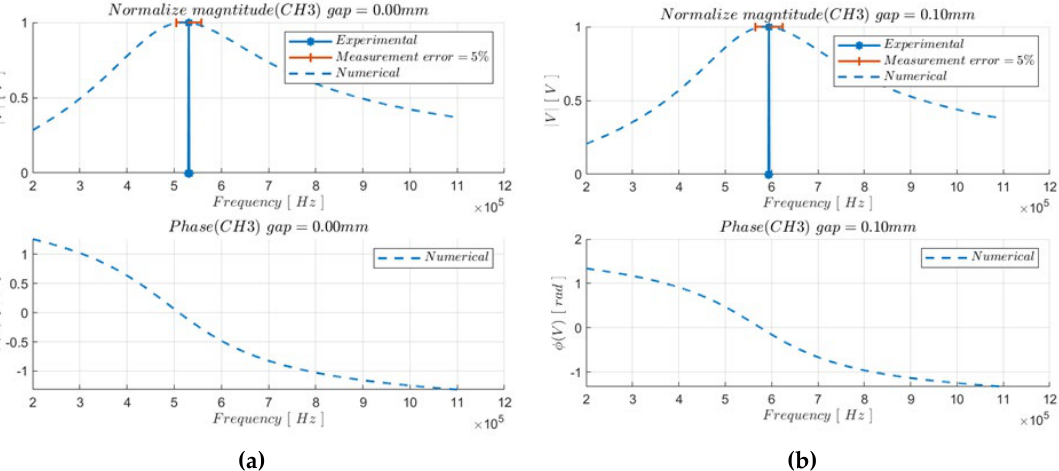
Figure 16. ( a ) Focus of the CH3 frequency response at 0.00 mm; ( b ) focus of the CH3 frequency response at 0.10 mm.